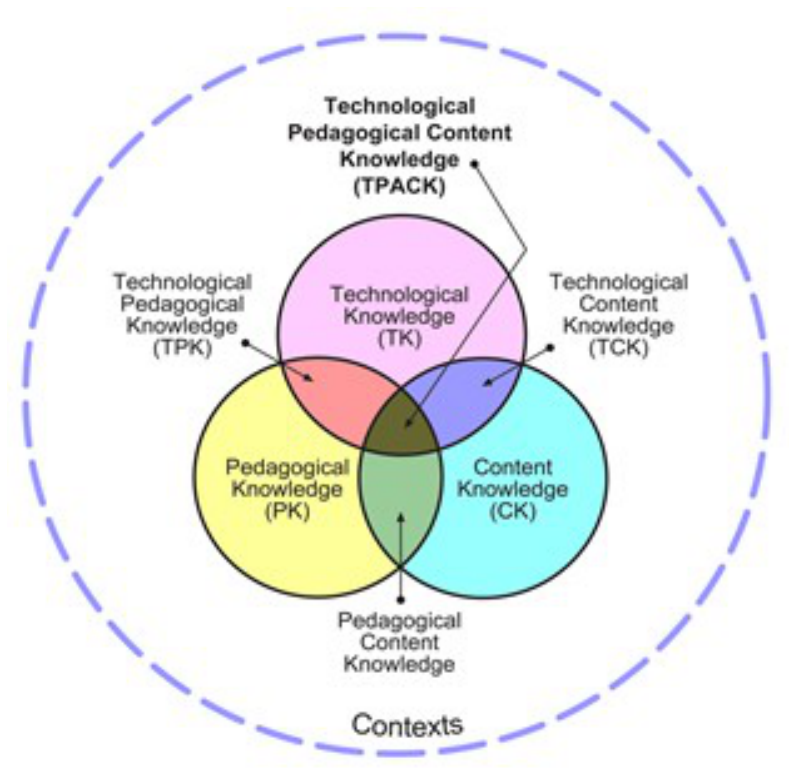
Figure 1 . The TPACK framework